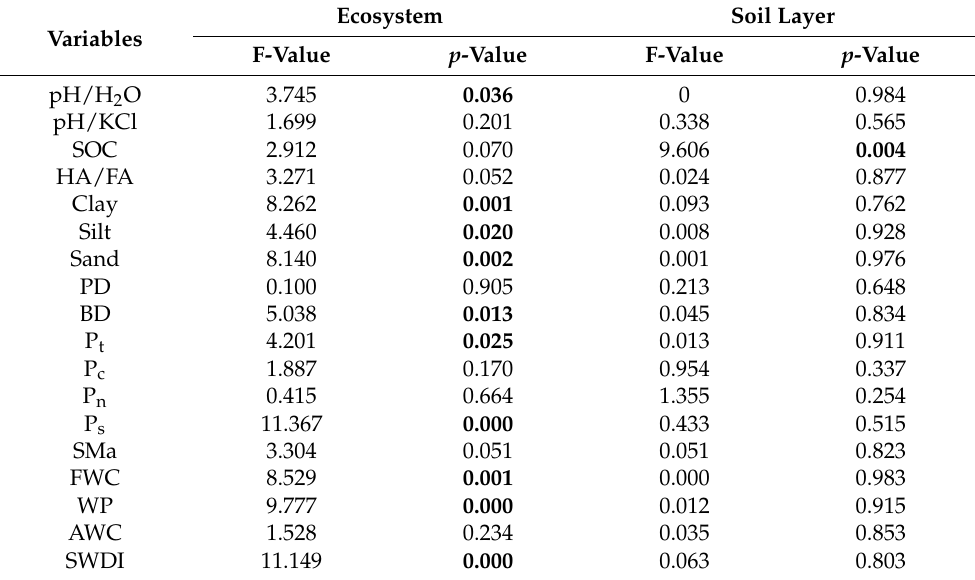
Table 6. Effect of ecosystems and soil layer on soil